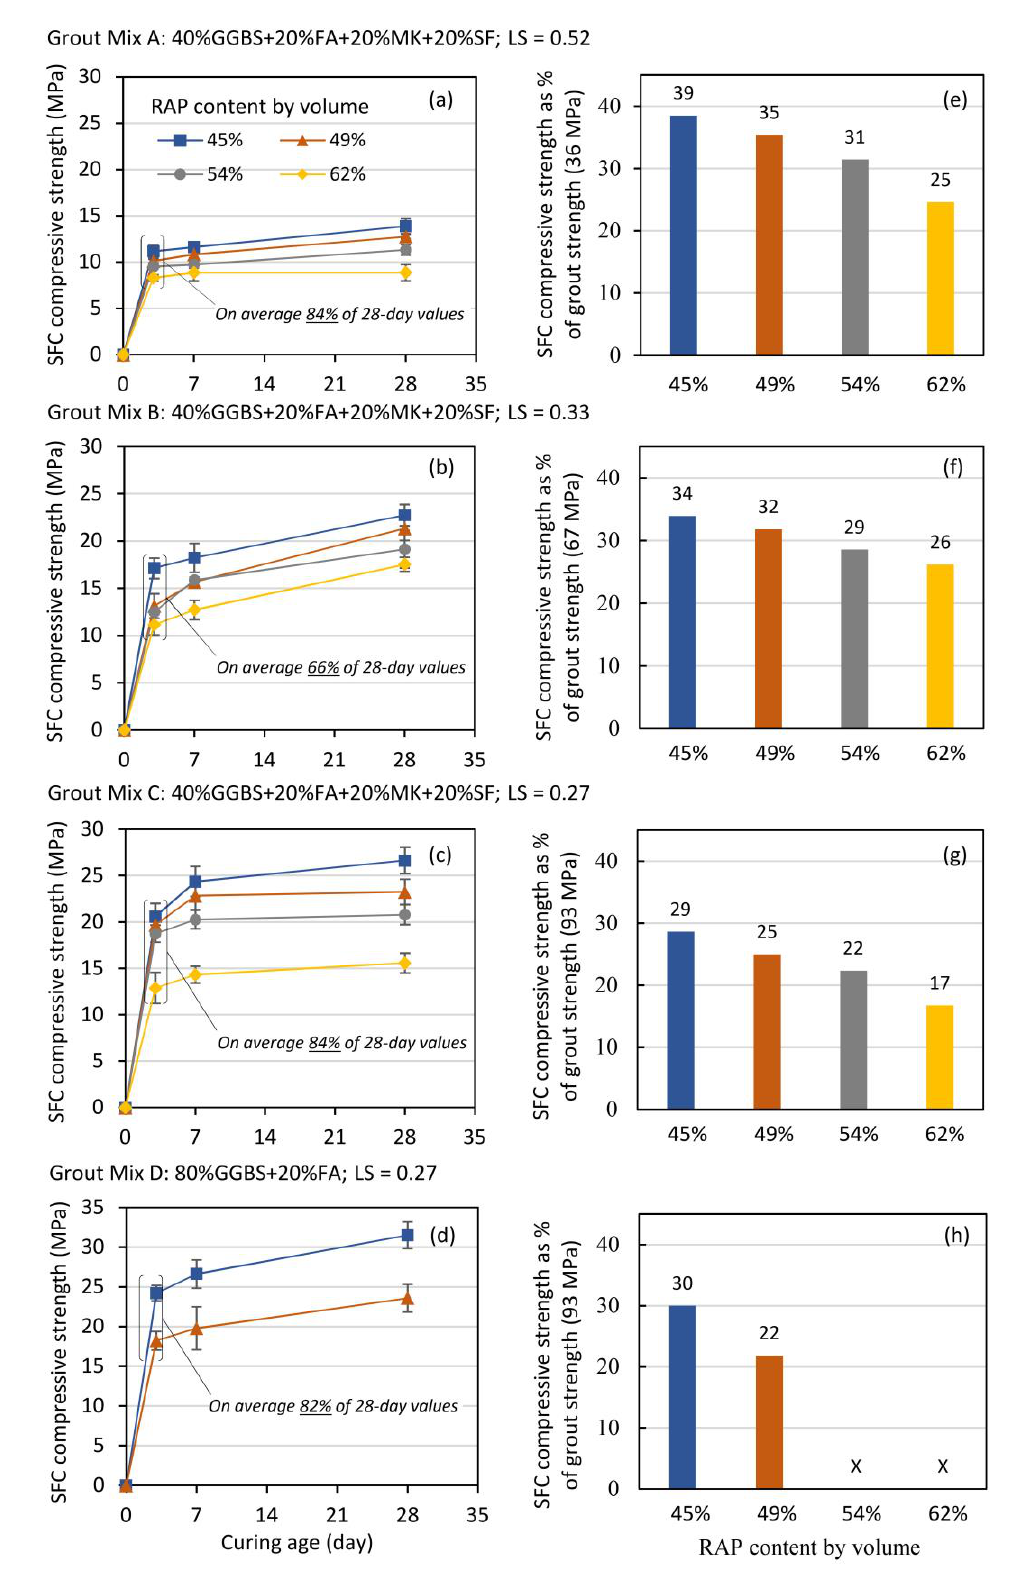
Figure 3. ( a – d ) SFC compressive strength development with time data; ( e – h ) 28-day SFC strength relative to the compressive strength of the parent grout at the same age.